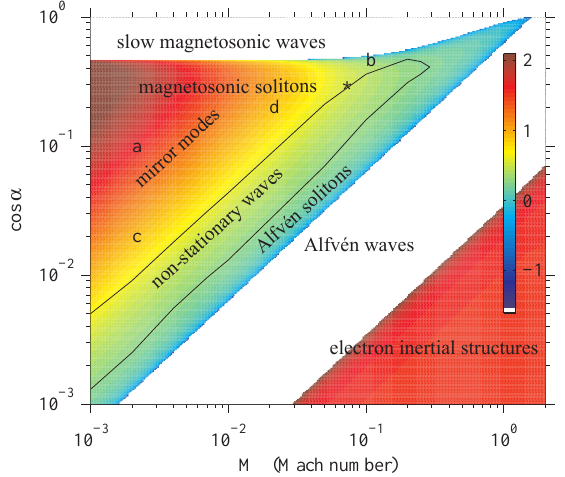
Fig. 4. Examples of soliton solutions in four points marked with letters a, b, c, d in Fig. 3. Black lines show normalized B and red lines normalized N . The distance x is in units of the ion inertial length λ i